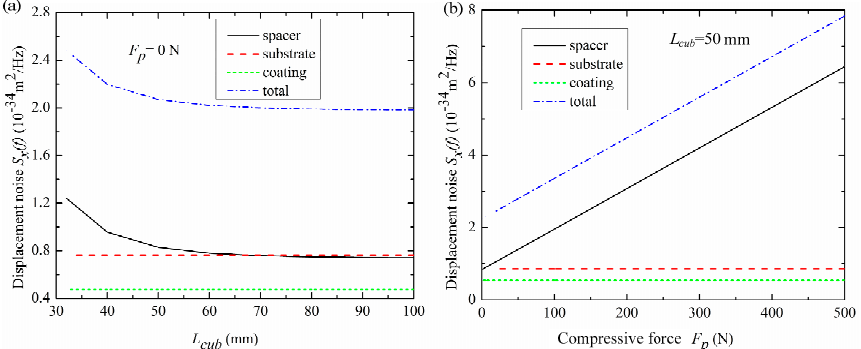
Figure 7. Contributions to the thermal noise of the optical length S x (f) as functions of the spacer length L cub and F p . The spacer is made of ULE. The substrates and coating of the two mirrors are FS and GaAs/AlGaAs crystalline, respectively. ( a ) The spacer length L cub . ( b ) Compressive force F p .